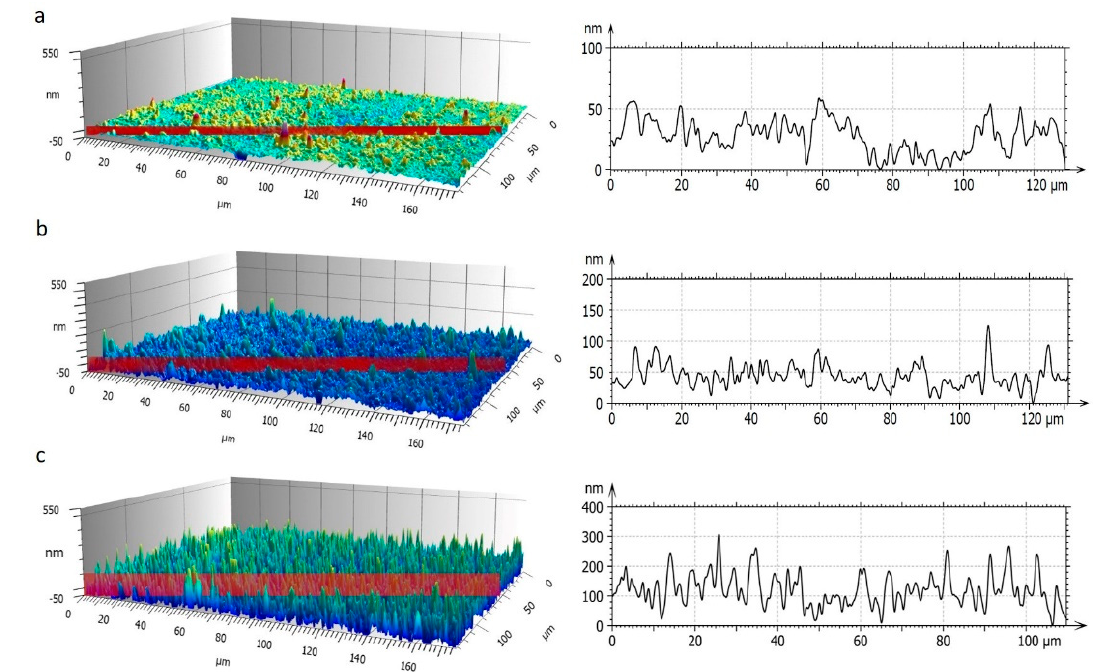
Figure 1. 3D images of samples and correlated roughness profiles acquired by 3D interferometric and confocal profilometer Sensofar S-Neox: ( a ) Sa = 28 ± 3 nm (1 g/L 1 layer); ( b ) Sa = 52 ± 4 nm (2 g/L 2 layers); ( c ) Sa = 70 ± 2 nm (0.5 g/L 10 layers).